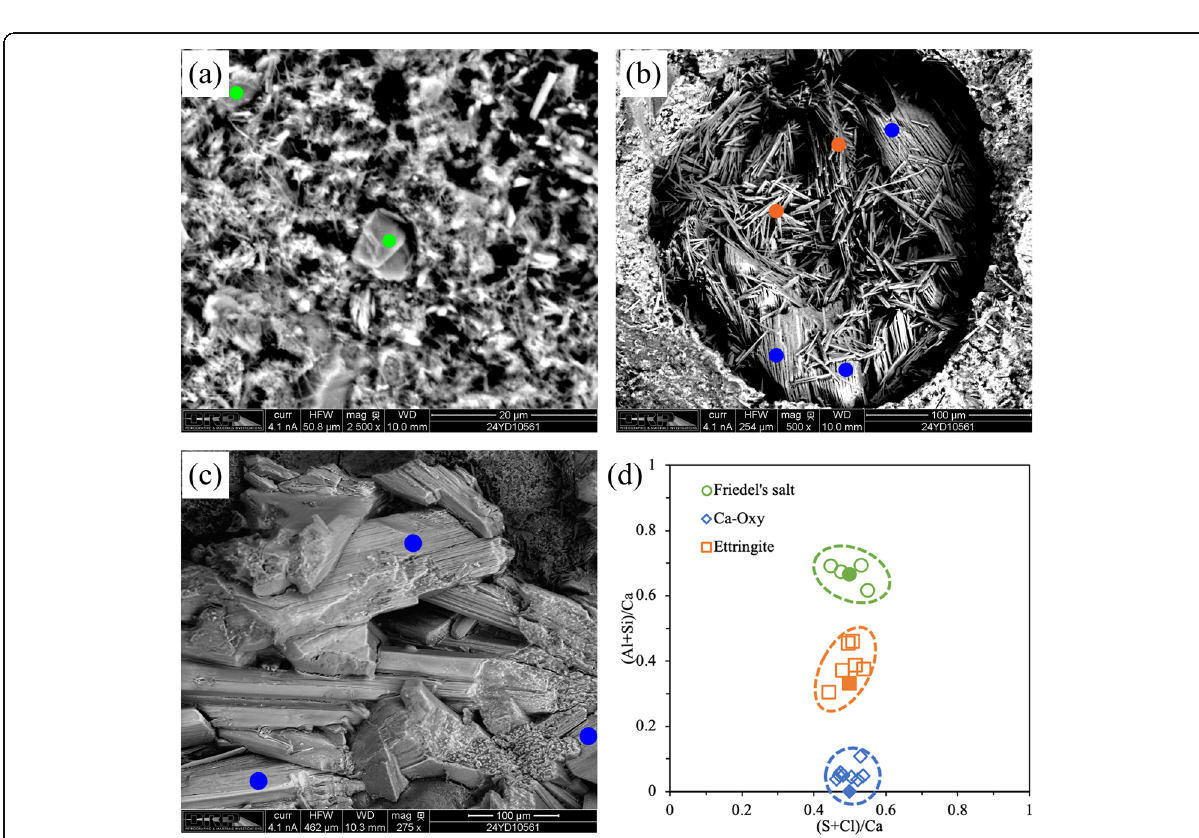
Fig. 7 a - c Backscattered electron (BSE) images of secondary deposits in a the paste matrix, b an air void and c a fresh fracture surface, respectively. Green circles: Friedel ’ s salt; blue diamonds: Ca-Oxy; orange squares: ettringite. d Atomic ratios obtained from EDX spectra in zones in ( a - c ). The solid shapes indicate the theoretical composition of the corresponding